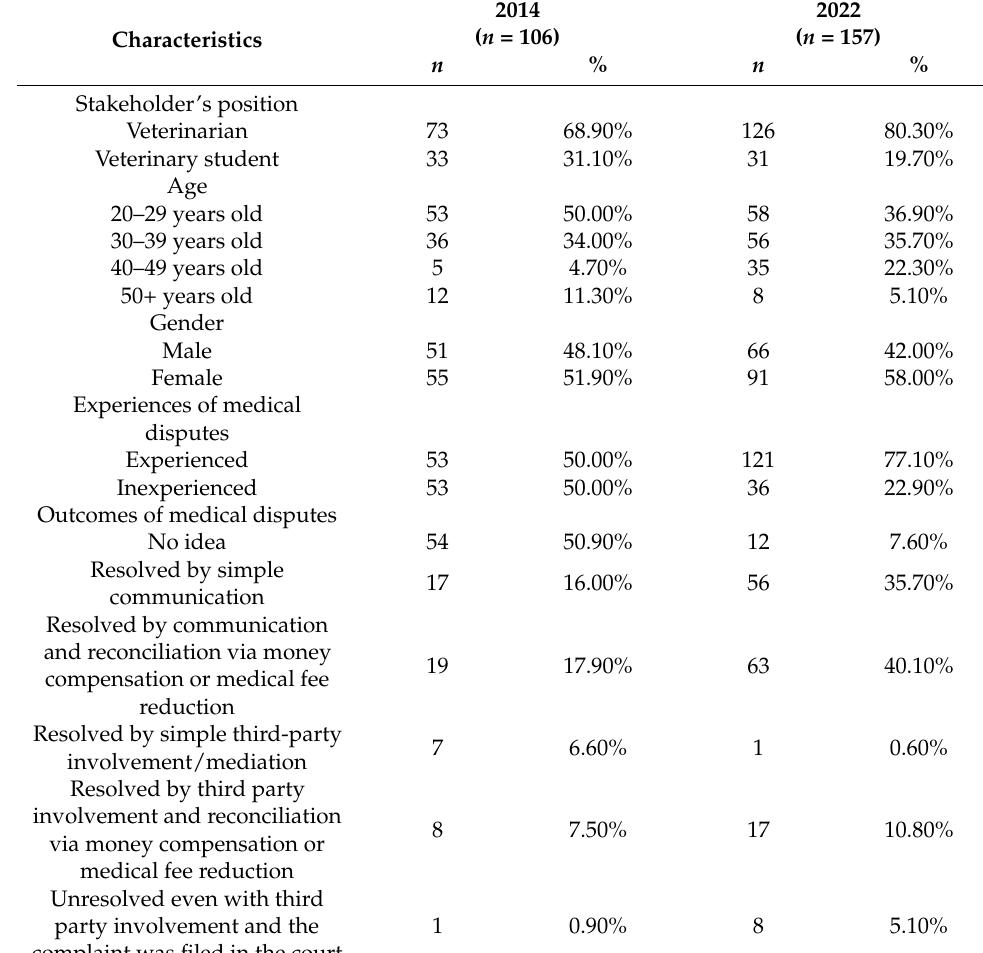
Table 2. Demographic characteristics distribution of participants in 2014 and 2022.